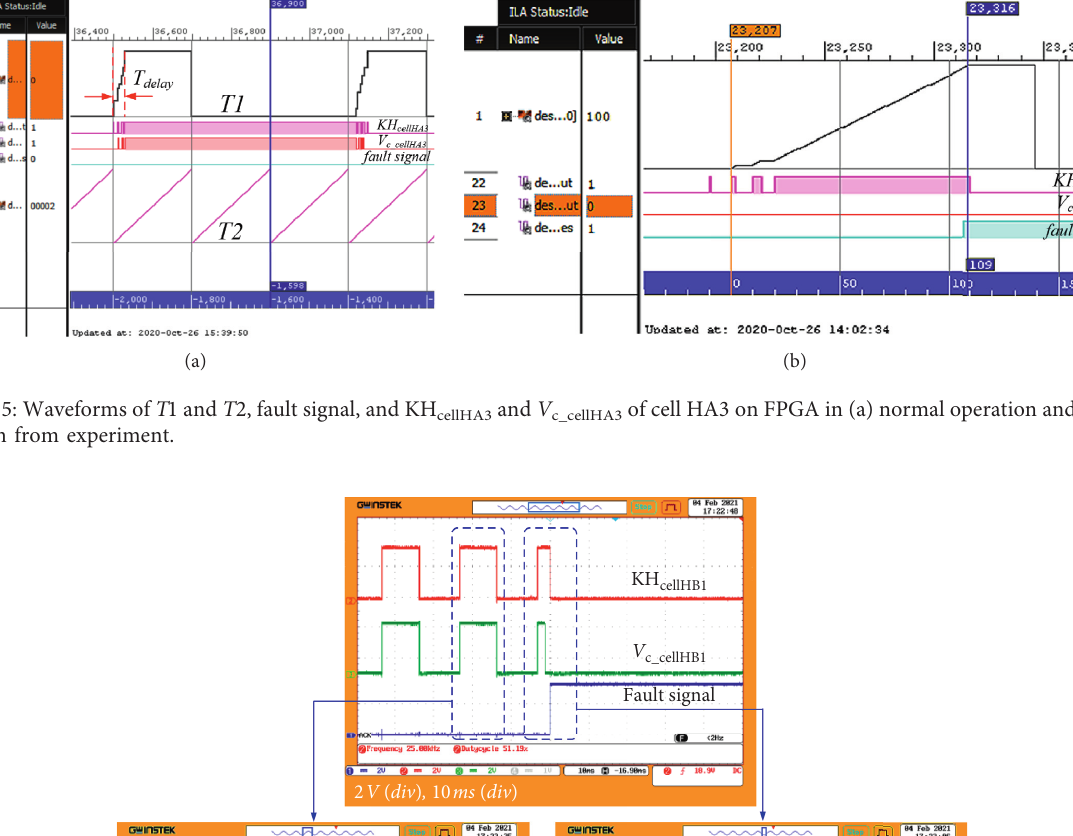
Figure 16: Waveforms of fault signal and KH cellHB1 and V c_cellHB1 of cell HB1 in (a) normal operation and (b) faulty condition from experiment.